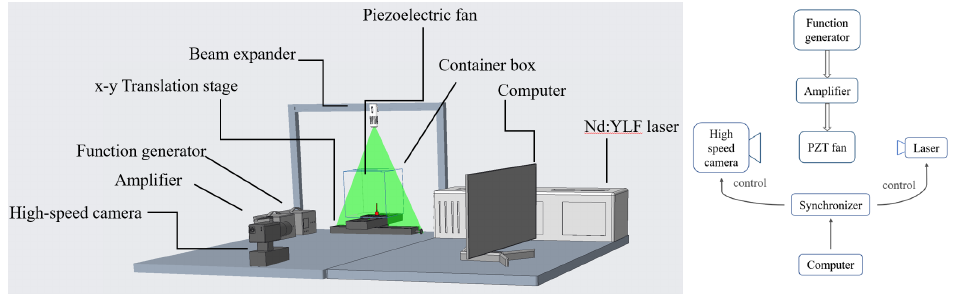
Figure 1. Schematic of PIV experiment setup.